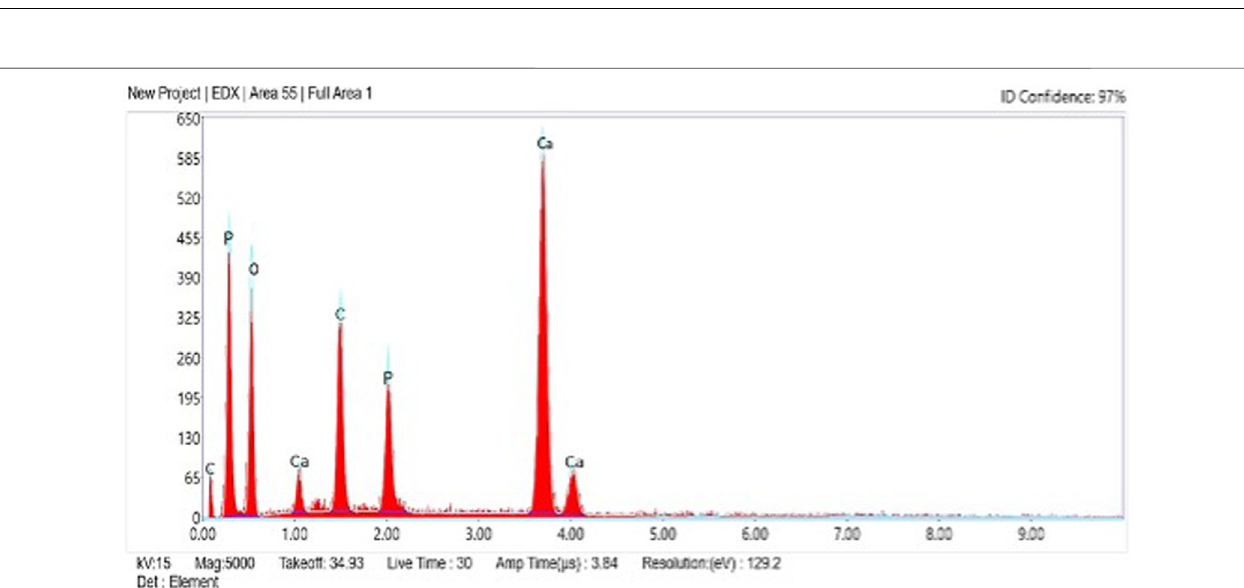
FIGURE 2 | SEM images of A. calamus rhizome extract derived HAp NPs.